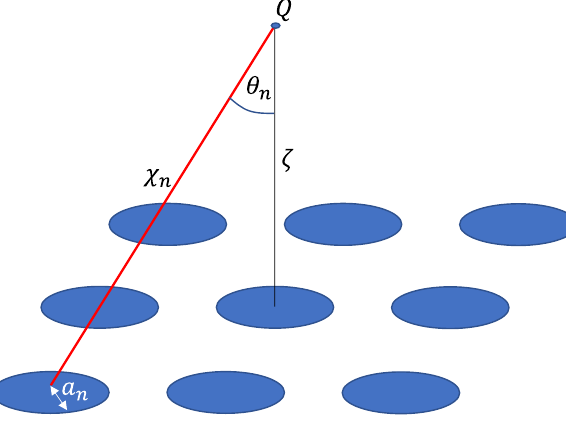
Figure 9. Geometry of the planar cymbal array.